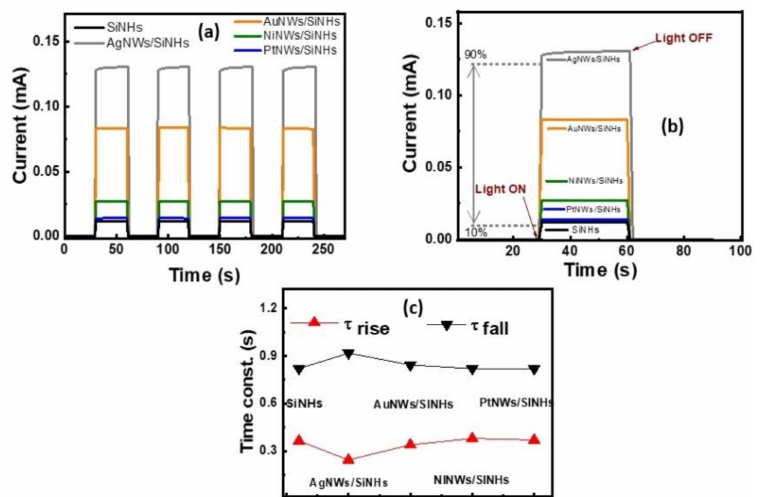
Figure 6. ( a ) Self-biased photocurrent response of the MeNWs/SiNHs photodetectors under on/off WL illumination. ( b ) Response time plots used to calculate the time constants. ( c ) The rise and fall time constants corresponding to each type of